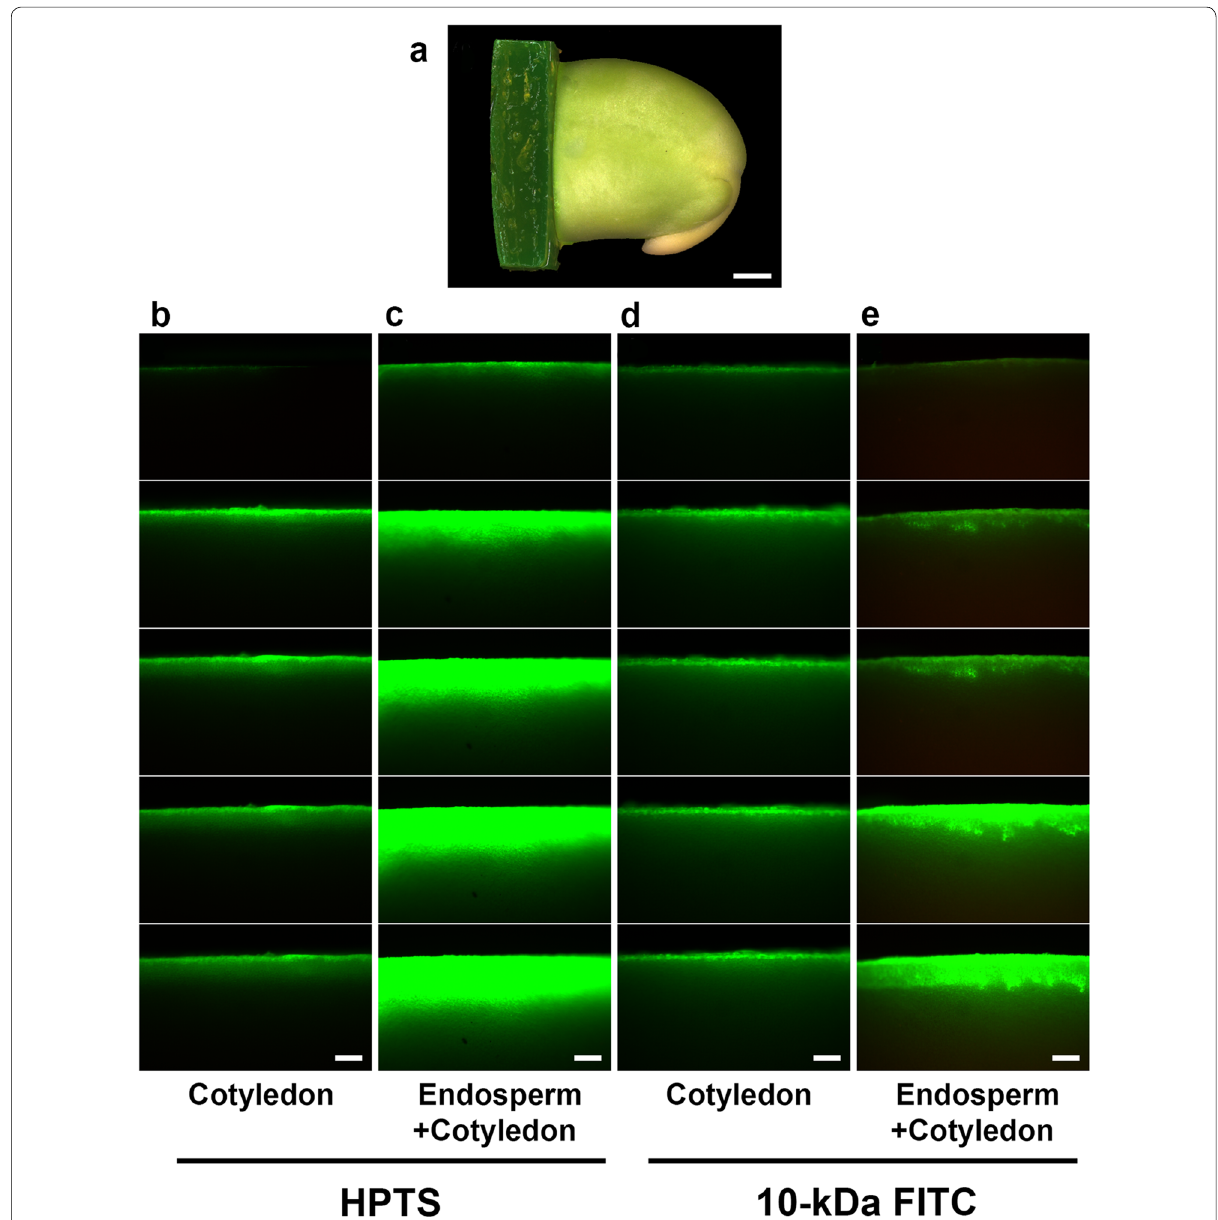
Fig. 5 Movement of HTPS and 10‑kDa FITC‑dextran in endosperm or cotyledon tissue. a Soybean seed was cut at the opposite site of the embryonic axis. The cut edge was contacted with agar gel with symplastic tracer. The tracer transferred to cells starting from the cut end of b cotyledon only or c endosperm on cotyledon with HTPS or d cotyledon only or e endosperm on cotyledon with 10‑kDa FITC‑dextran at 0, 0.5, 1, 2, and 3 min (from upper to button). Scale